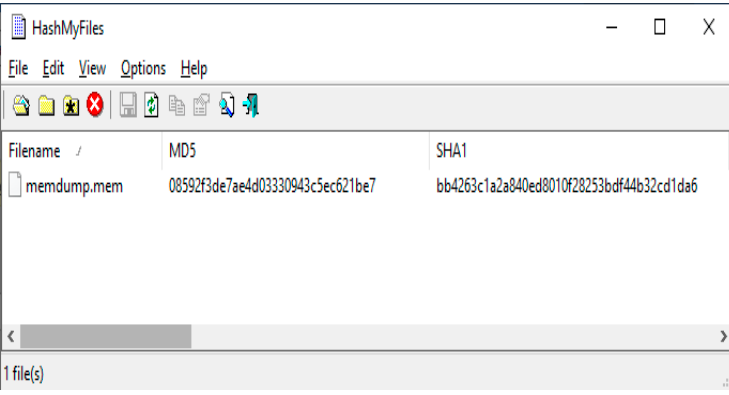
Figure 13. Hashing the captured data.